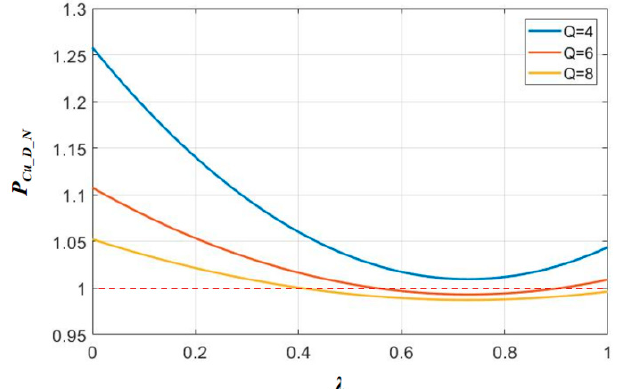
Figure 9. Equivalent circuit of the dual-channel system.